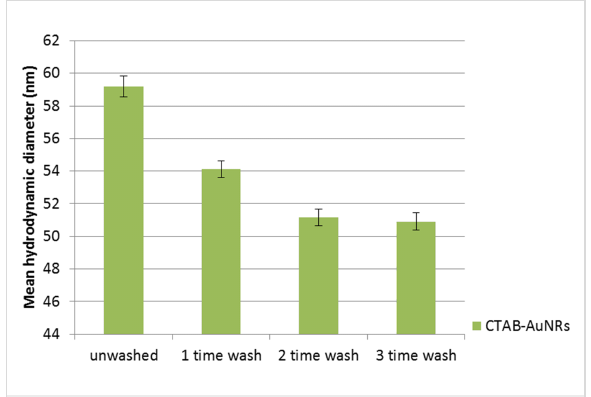
Figure 5: Mean hydrodynamic diameters of as-synthesized AuNRs (unwashed) and AuNRs washed three times by centrifugation. The hydrodynamic diameter is inferred from the diameter of the outermost encapsulation layer on a particle. with PEG-SH or PEO–PPO–PEO are found to be larger than those of AuNRs. This is mainly due to the solvated polymer layers of PEO–PPO–PEO or PEG-SH on the AuNRs surface. In our study, only AuNRs which underwent three washing treatments were used for functionalization with polymer mole- cules. The hydrodynamic diameter of the AuNRs was deter- mined to be 55 and 58 nm after passivating their surface with PEO–PPO–PEO and PEG-SH molecules. For in vitro imaging study, OSCC cells were treated with AuNRs functionalized with either PEG-SH or PEO–PPO–PEO